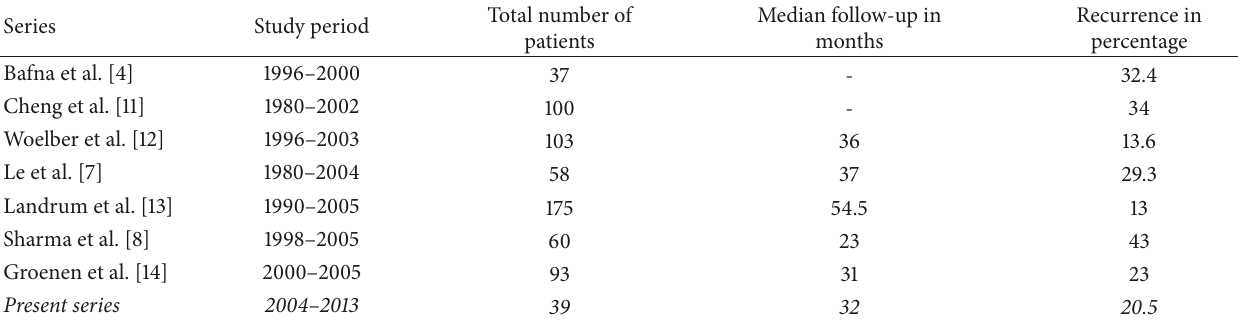
Table 4: Recurrence in various